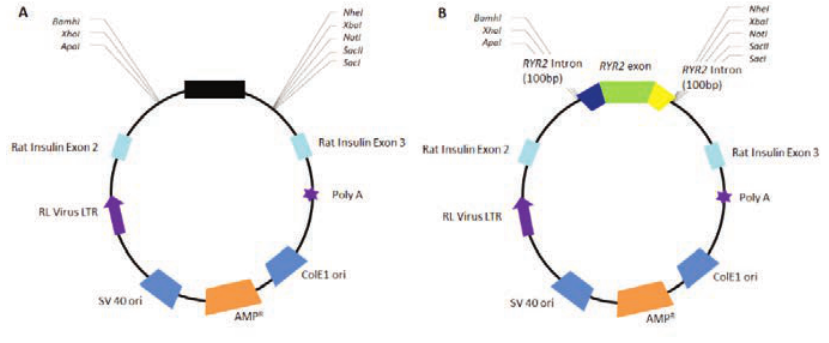
Figure 1. Schematic representation of pSpliceExpress vector before (A) and after (B) the insertion of RYR2 exonic and intronic sequences. The black rectangle in A